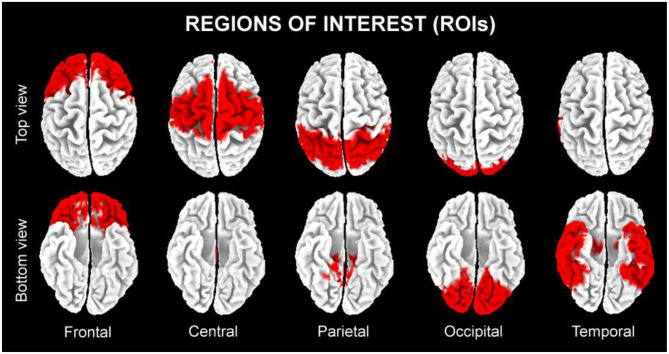
The five regions of interest (ROIs) where we averaged the solutions of the exact low-resolution brain electromagnetic tomography (eLORETA) freeware to estimate the cortical source of eyes-closed resting state electroencephalographic (rsEEG) rhythms recorded in the present seniors in the quiet wakefulness.